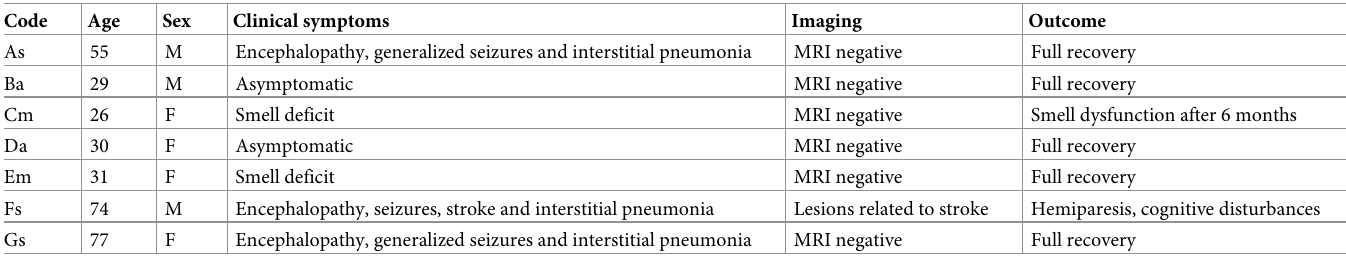
Table 2. Characteristics of the enrolled COVID-19 patients relevant for the study.